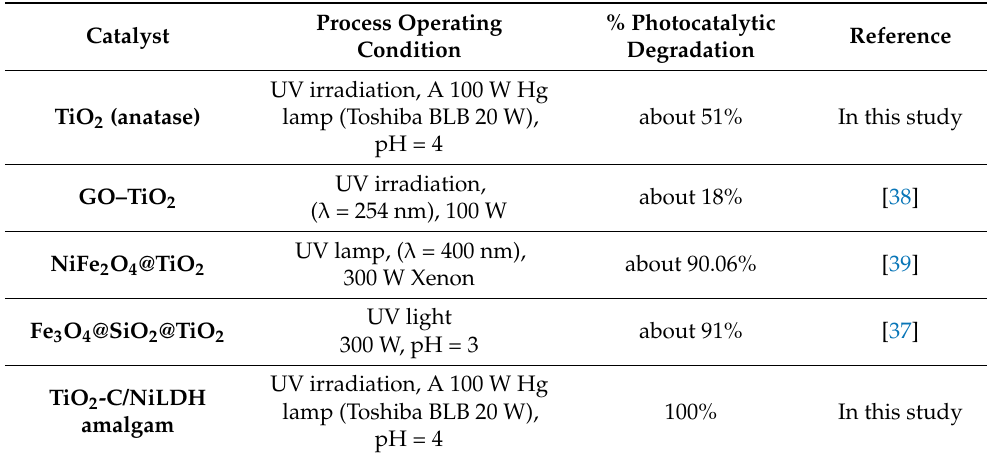
Table 3. Literature review on comparison of the catalytic activity of as-prepared samples with some typical titania-based catalysts for degradation of